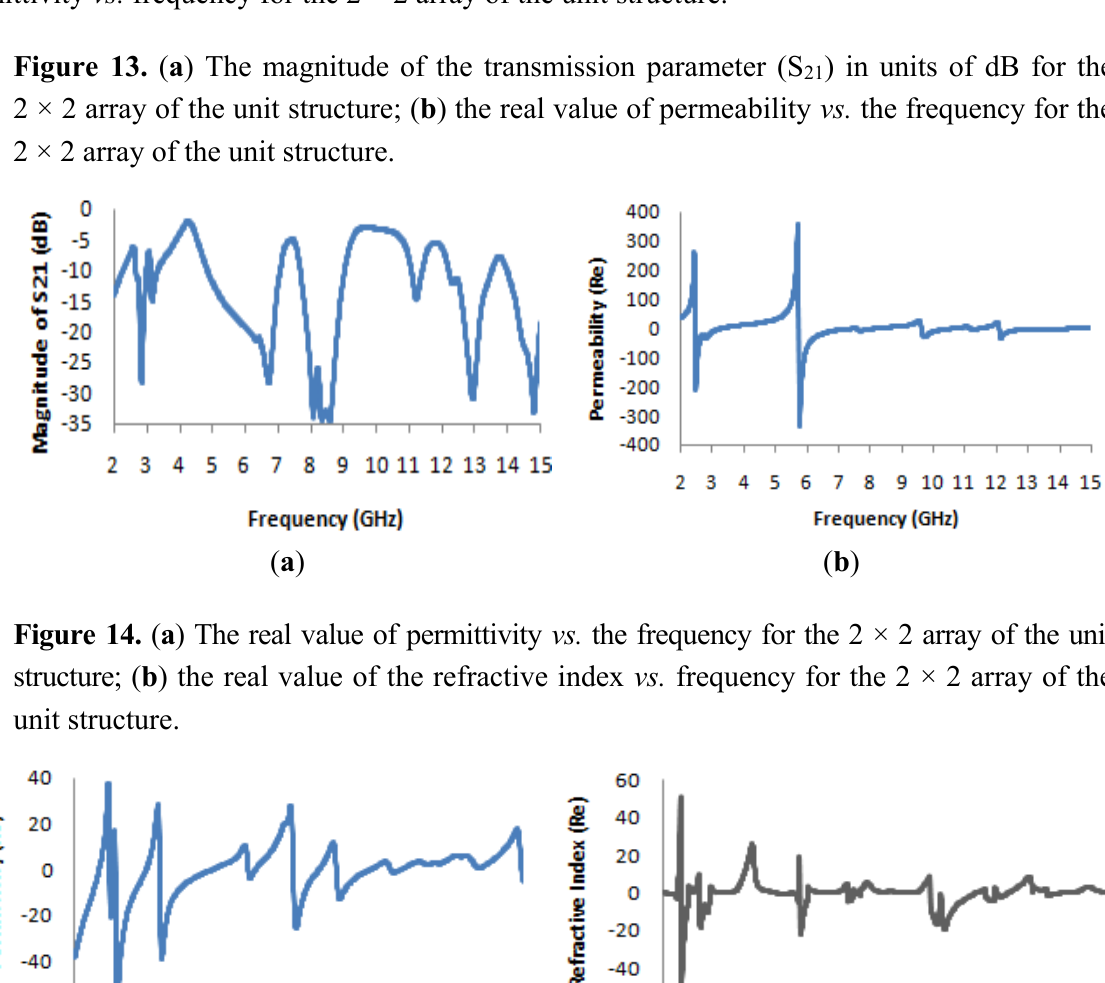
) in units of dB for the 21